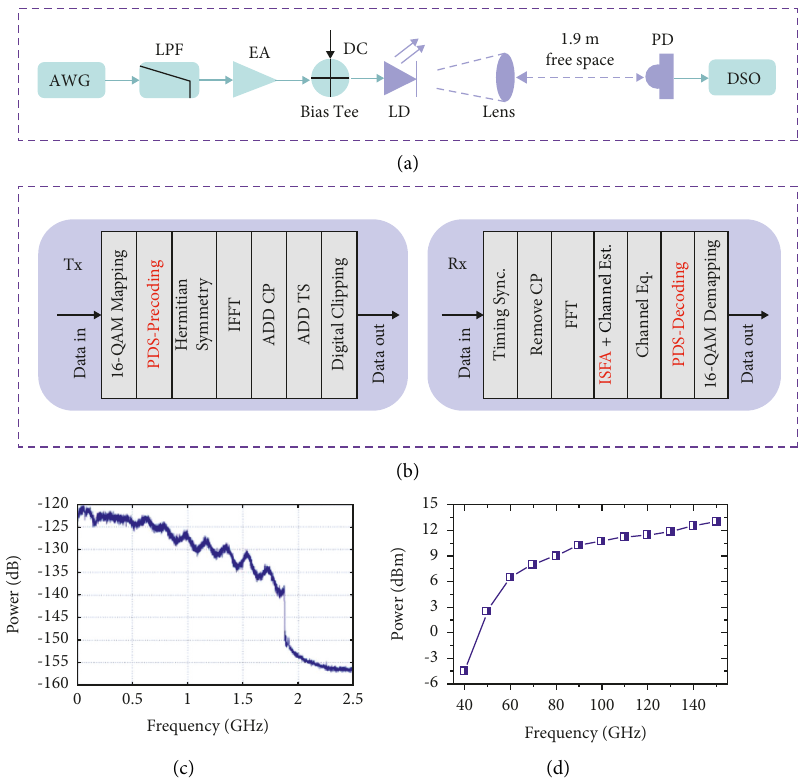
Figure 4: (a) The experimental structure diagram of the VLC-based intelligent transportation communication system; (b) the corre- sponding DSP; (c) the spectrum of the received DMT signal; and (d) the output power versus I